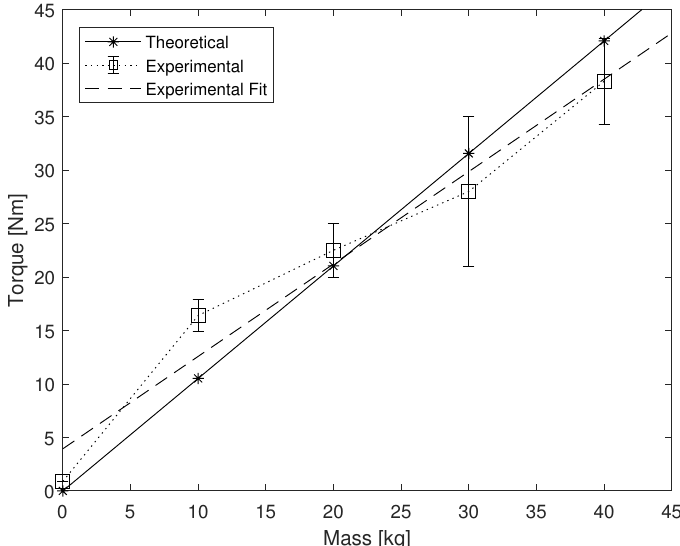
Figure 5. Maximum recorded braking torque before slipping occurred.